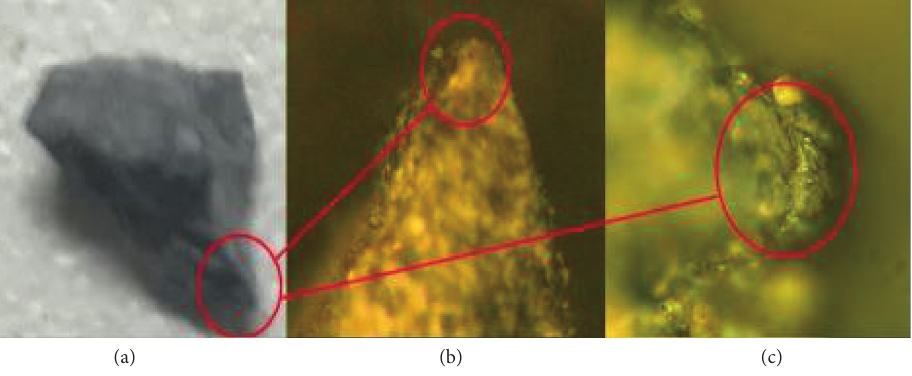
Figure 4: Microstructures of angular